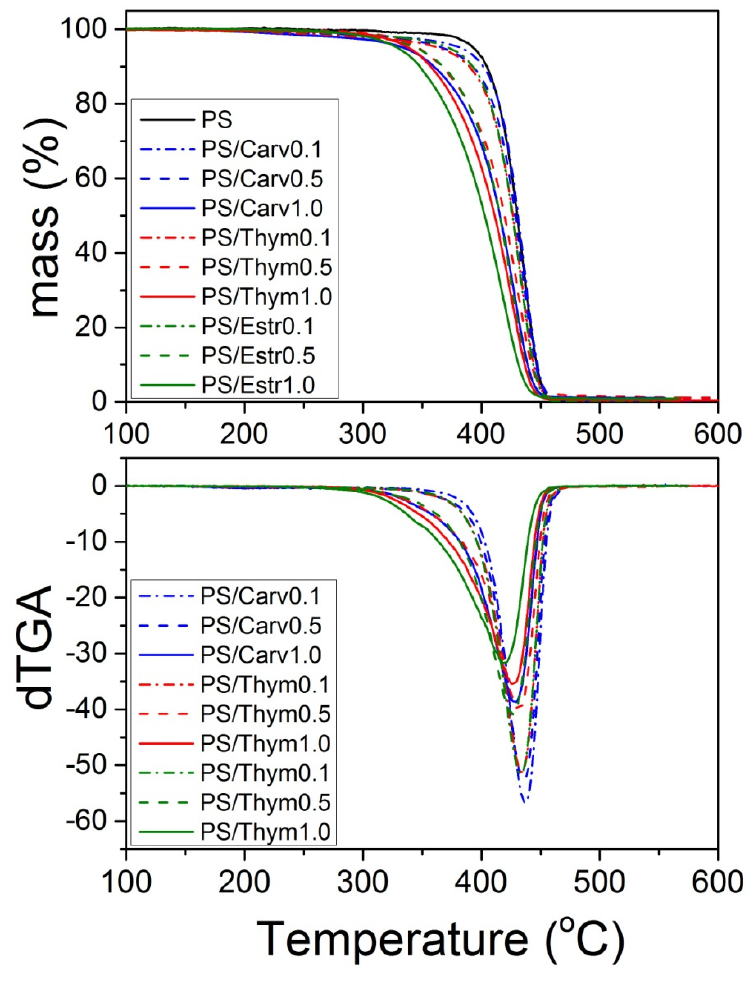
Figure 10. Mass loss and differential TGA curves obtained during heating at 20 °C/min of PS with model thymol, carvacrol and estragol at 0.1, 0.5 and 1.0 wt %.